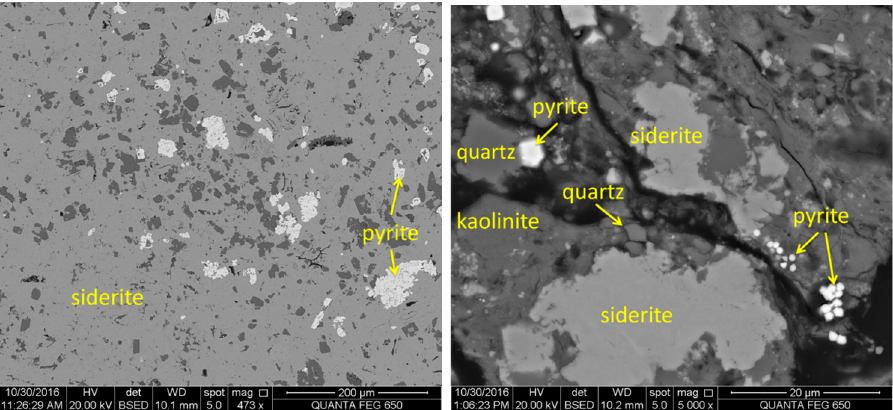
Figure 16. Pyrite and siderite coexisted in SGT1-11, SEM back-scattering images.